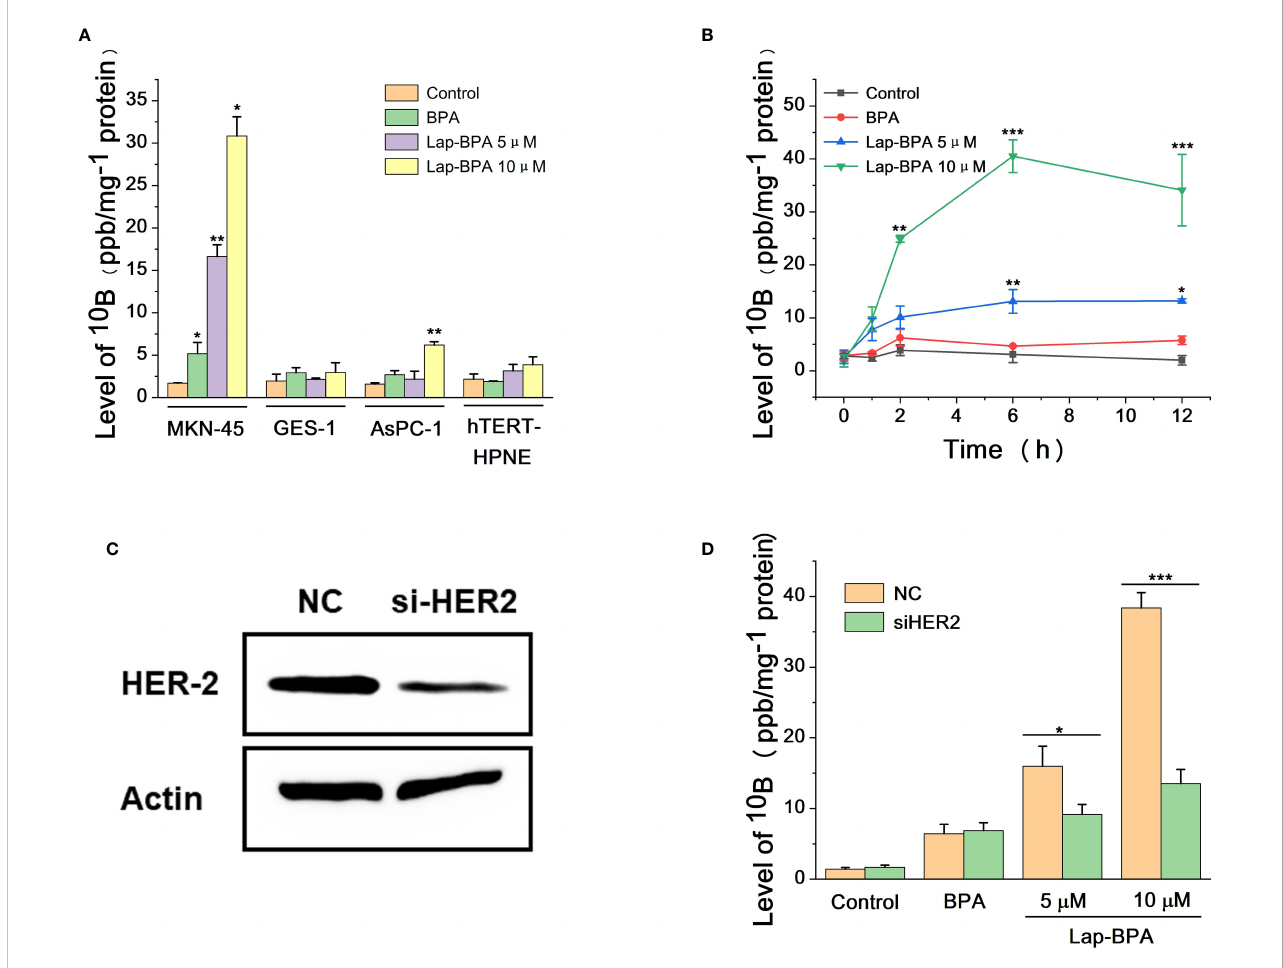
FIGURE 3 The uptake of 10 B by tumor cells and normal cells. (A) After different concentrations of Lap-BPA and MKN-45, GES-1, AsPC-1 and hTERT-HPNE cells, the level of 10 B in these cells was detected by ICP-AES, respectively, with 1 mg of total protein as the internal reference. Concentration of compounds co incubated with cells: BPA, 10 m M; Lap-BPA, 5 m M and 10 m M. (B) Different concentrations of Lap-BPA were co-incubated with MKN-45 cells, and the level of 10 B in MKN-45 cells changed with the co-incubation time. (C) Western blot analysis of MKN-45 cells transfected with siRNA targeting HER2. (D) The 10 B level of MKN45 cells transfected with siRNA targeting HER2 after co-incubation with various concentrations of Lap-BPA. Data are presented as mean ± SD determined by Student ’ s t-test. *p < 0.05, **p < 0.01, *** p < 0.001 vs control